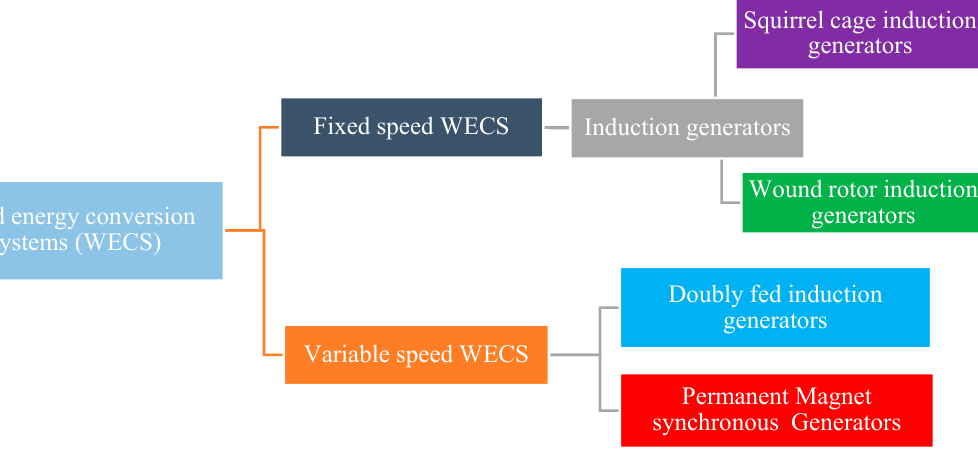
Figure 4. Types of wind turbine generators.